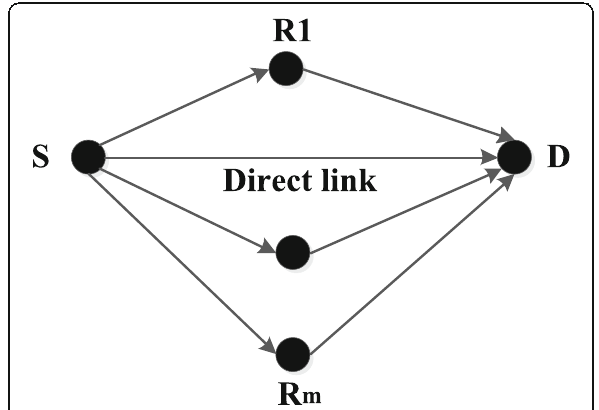
Fig. 2 Simplified system model considering one source, m relays, and one destination. The figure shows the system model. In this work, the transmission process is divided into two phases, phase I and phase II. In phase I, an information source broadcasts the message and multiple relays and the destination receive the message. In phase II, according to the proposed relaying strategy, the multiple relays transmit the received message to the destination. After receiving several copies of the information sequences, the destination jointly decode the